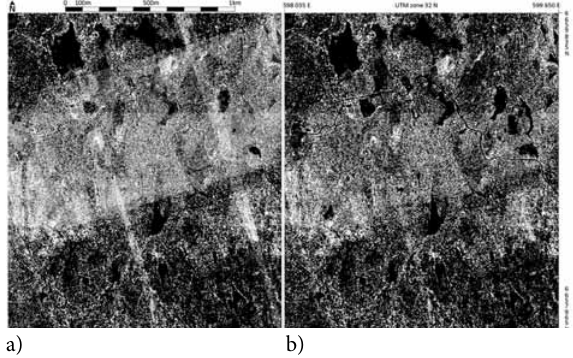
Fig. 4. NDVD of a part of the forest at Tømte. (a) NDVD for vegetation returns 0.0–2.0 m above the ground.